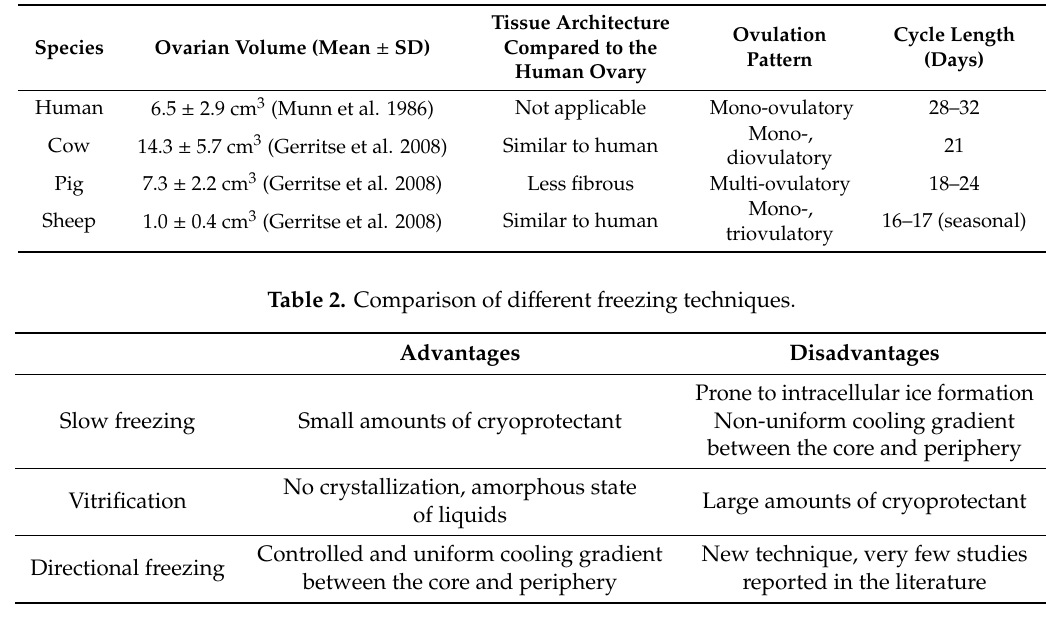
Table 1. Ovarian characteristics in large animal models compared to the human ovary.